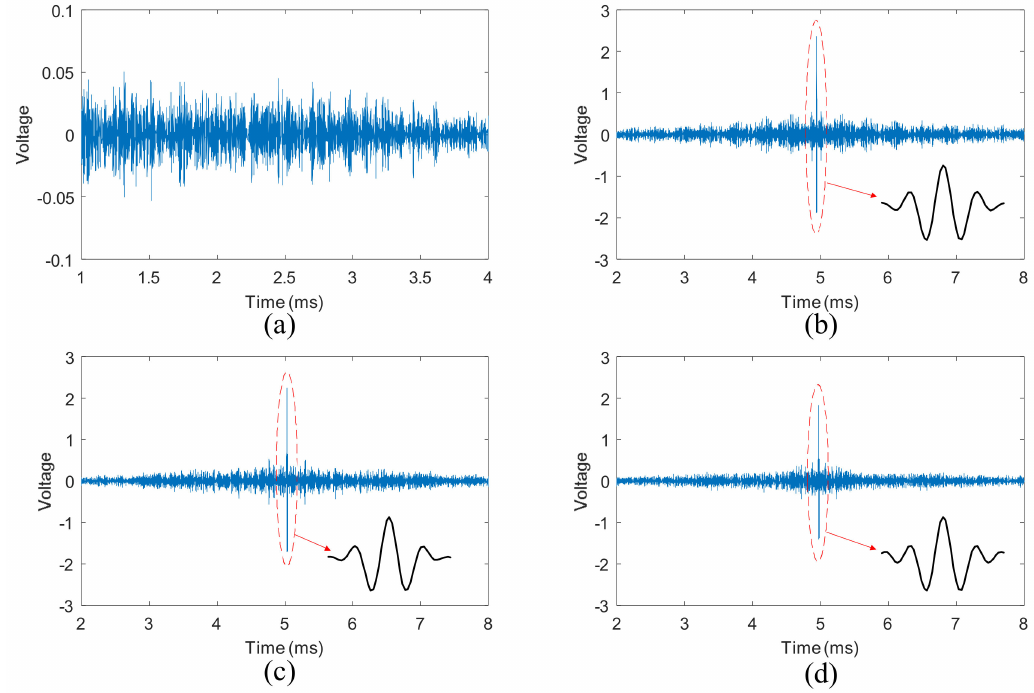
Figure 5. Reconstructed signals using TR method acquired from single bolt structure: ( a ) response signal in step 2; ( b ) reconstructed signal with 14 Nm torque; ( c ) reconstructed signal with 10 Nm torque; ( d ) reconstructed signal with 2 Nm